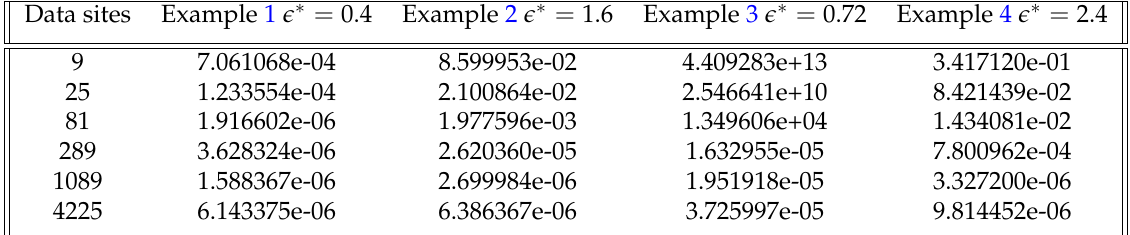
Figure 9. Interpolant for Example 4 and its corresponding data sites Table 6. RMSE for the examples considered with their respective optimal shape parameter ( (cid:101) ∗ ) Data